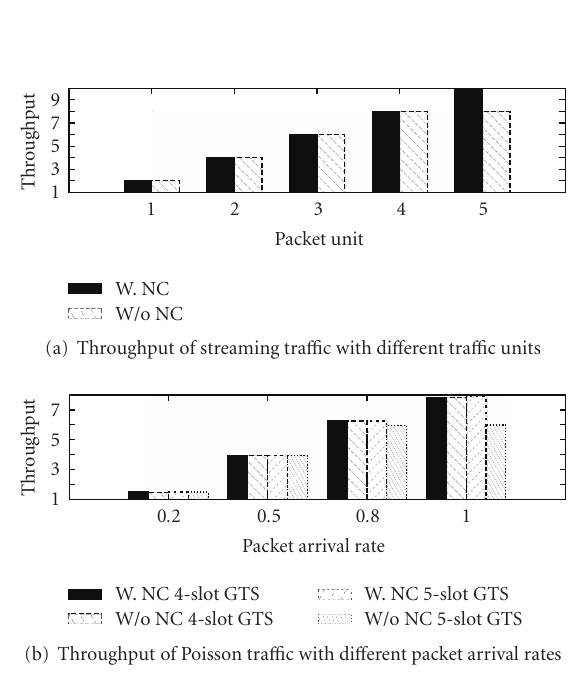
Figure 6: Throughput